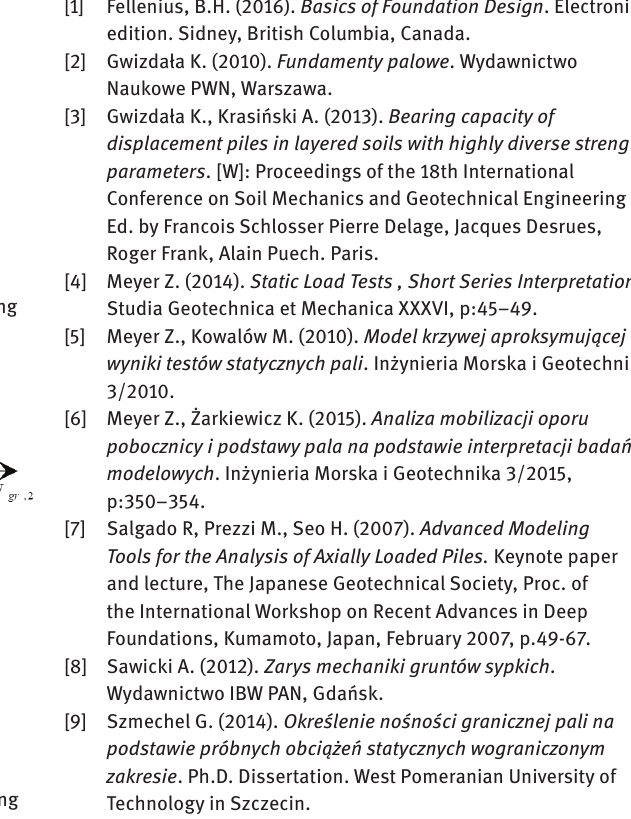
Figure 8: Calculated skin and toe resistance mobilisation following the settlement – pile